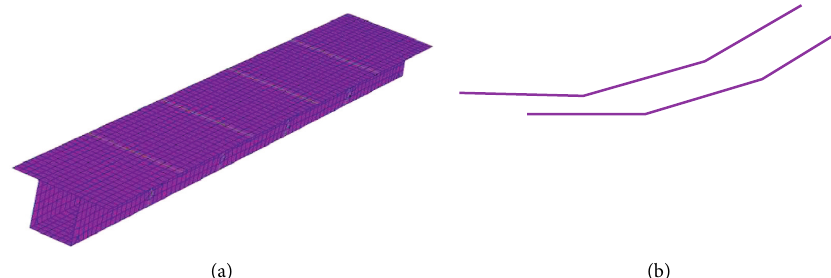
Figure 14: Numerical modeling of the test specimen: (a) finite element mesh; (b) tendons.